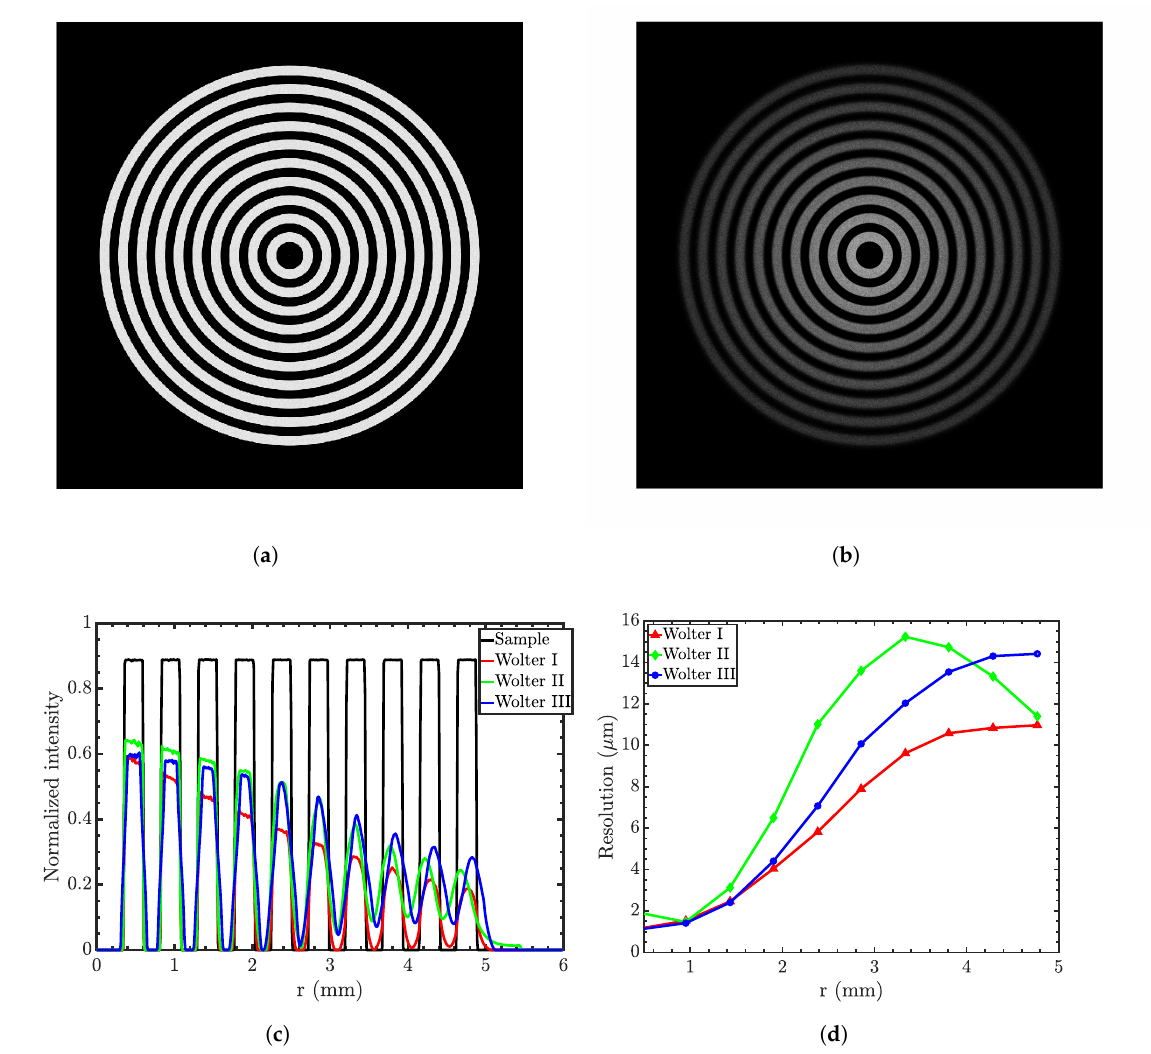
Figure 13. ( a ) Concentric rings sample; ( b ) the magnified image in the Wolter I microscope; ( c ) ideal edge-spread function (ESF) and that obtained by three types of Wolter mirrors; ( d ) the resolution at the focal plane as a function of the distance from the optical axis of the three microscopes. Simulations were conducted using 10 9